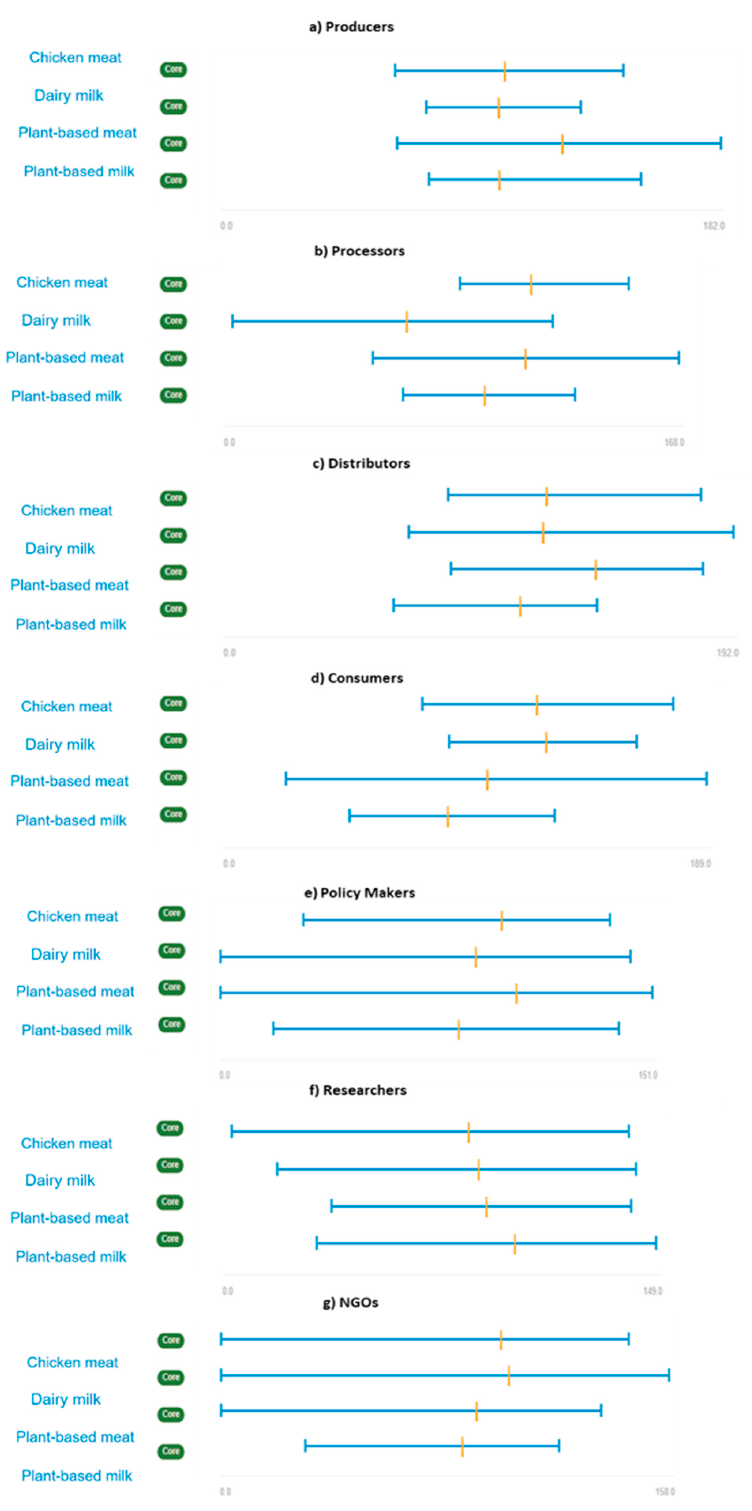
Figure A2. Uncertainty by stakeholder group: ( a ) Producers; ( b ) Processors; ( c ) Distributors; ( d ) Consumers; ( e ) Policymakers; ( f ) Researchers; ( g ) NGOs. The orange cross-line represents the average degree of uncertainty. The blue line refers to extreme values (the left and right ends show the largest and lowest degrees of uncertainty).